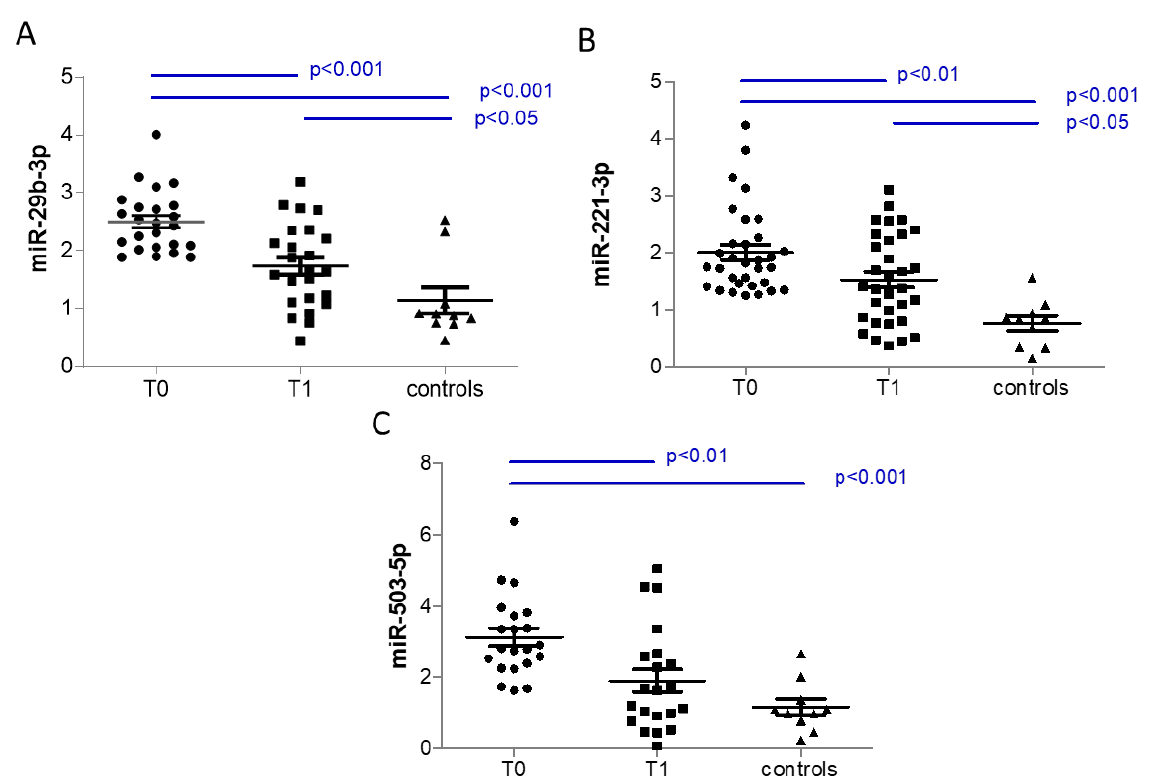
Figure 2. Effects of Sacubitril/Valsartan treatment on patients in the upper tertile of ( A ) miR-29b-3p (n = 24), ( B ) miR-221-3p (n = 32), and ( C ) miR-503-5p (n = 21) at baseline (T0) and after 6 months after the maximum tolerated dose was reached (T1). Data are expressed as mean ± SEM. p -value from paired t-test for comparison of T0 and T1. p -value from ANOVA for comparisons with control subjects (controls n = 10). Table 4. Spearman’s correlation between levels of circulating miRNAs and clinical parameters at the